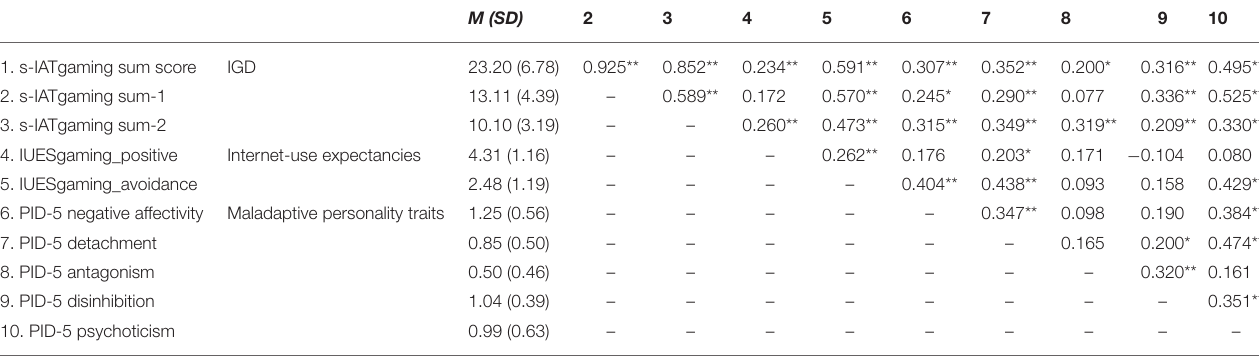
TABLE 1 | Bivariate correlations between the scores of the s-IATgaming and the applied scales.